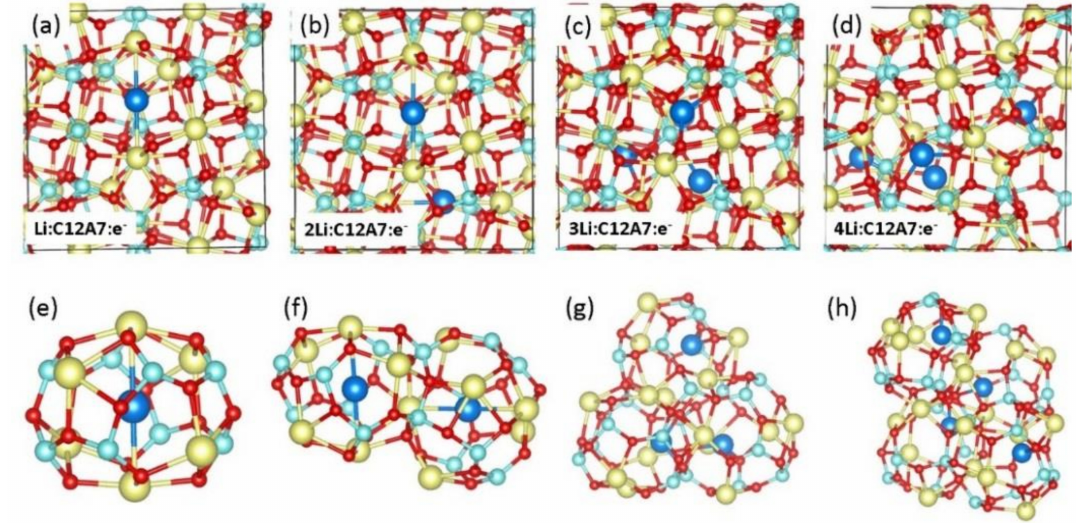
Figure 4. ( a – d ) Relaxed structures of Li.C12A7:e − , 2Li.C12A7:e − , 3Li.C12A7:e − and 4Li.C12A7:e − and ( e – h ) the corresponding relaxed cages occupying Li atoms. Table 2. Encapsulation energies, Bader charges on the encapsulated Li atoms, magnetic moments of the encapsulated complexes, Ca-Ca cage pole distances, Li-O bond distances and volume changes due to the encapsulation. The total Bader charges are shown in parentheses.